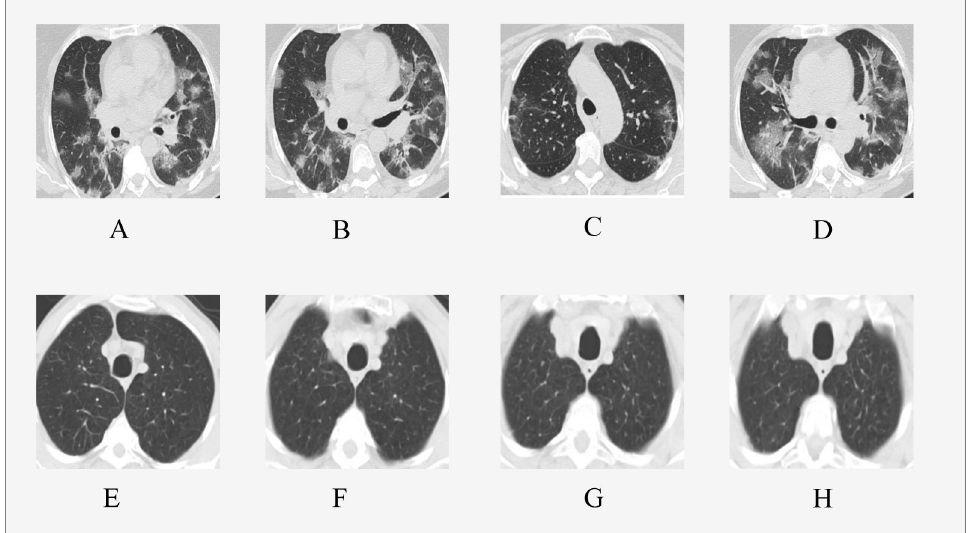
Fig 2. A sample of CT-scan images. (A-D) COVID-19 positive cases and (E-H) COVID-19 negative